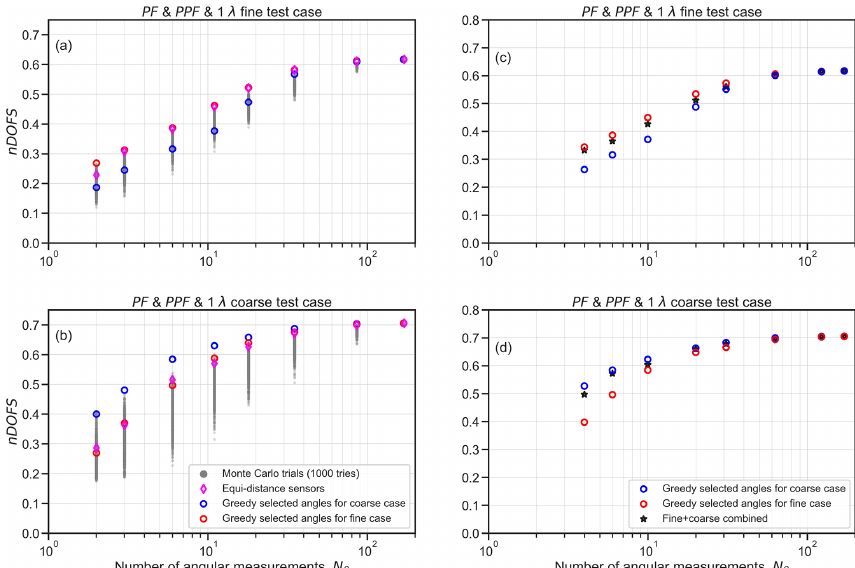
Figure 10. Panels (a) and (b) show the nDOFS values for optimized angular configurations for different detection angle numbers based on reductive greedy algorithms. The red points correspond to optimized configurations of the fine-aerosol test case, while the blue points correspond to the optimal detection angle configuration of the coarse-aerosol case. The grey dots are results of Monte Carlo simulations of 1000 random angular configurations for each case of detection angle numbers. In (c) and (d) the black dots correspond to the normalized nDOFS values for the combined optimal configurations of fine and coarse test cases.